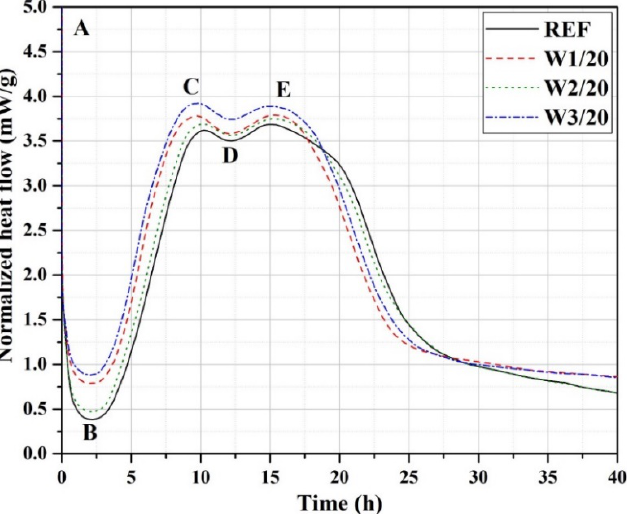
Figure 5. Heat release profiles of paste specimens.